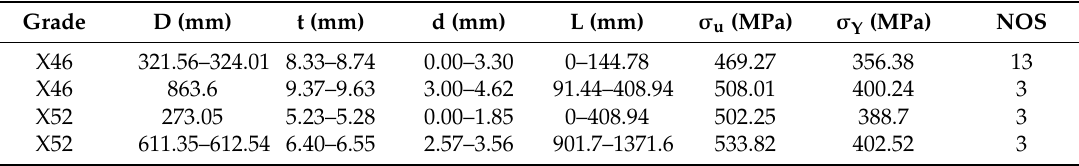
Figure 2. Finite Element Modelling (FEM) supporting and acting pressures on the modelled 1600 mm long X46 and X52 pipe. Table 1. Characteristics of the pipes used for Finite Element Modelling (FEM).